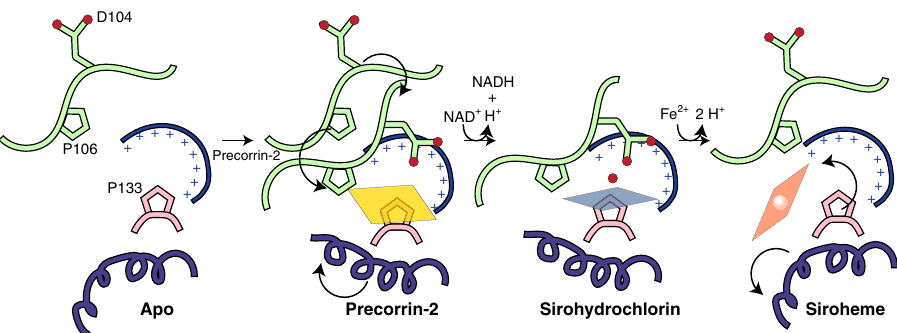
Fig. 7 CysG ʼ s bifunctional dehydrogenase/chelatase active site. Model for the evolving sirohydrochlorin dehydrogenase product to chelatase substrate, on to the fi nal